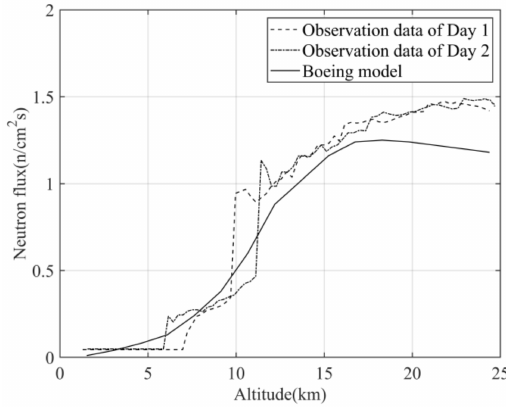
Figure 10. The neutron flux profiles on Day 1 (solid line) and Day 2 (dot dash line) and in the Boeing model (dash